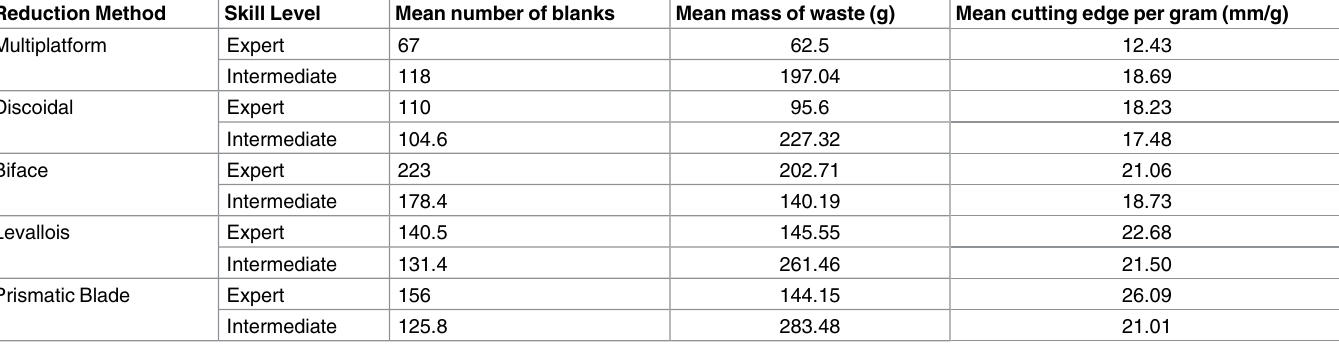
Table 3. Number of blanks, mass of waste and cutting edge per gram values between the expert knapper (N = 2 for all five technologies) and inter- mediate knapper (N = 5 for all five technologies) for each technology. Reduction